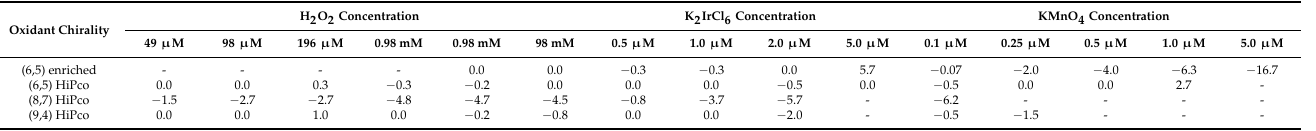
Figure 9. Detectable concentration ranges of ( a ) H 2 O 2 and ( b ) K 2 IrCl 6 and KMnO 4 for each chirality. The blue line shows the detectable range of the (6,5) chirality of (6,5) -enriched SWNT complex. The green line, brown line, and purple line indicate the detectable range of the (6,5), (8,7), or (9,4) chirality of the HiPco SWNT complex, respectively. Table 2 shows the peak shift in the absorption spectra of each chirality for the different concentrations of oxidants. Table 2. Absorption spectra peak shift for each chirality by the oxidant concentration. The data are presented as the average of three independent